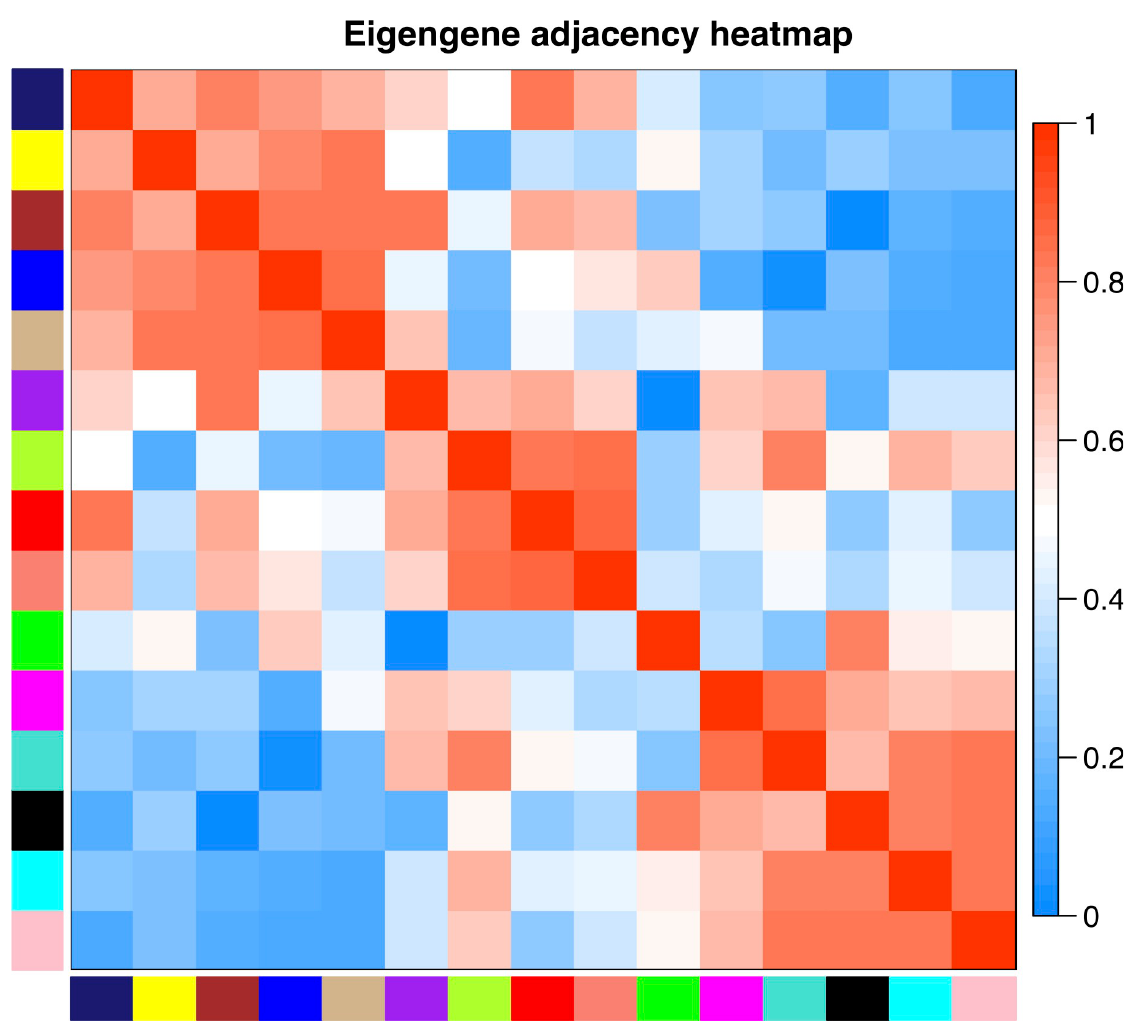
Fig 2. Adjacency heatmap showing the relationships among the module eigengenes. Module eigengenes can be thought of as the weighted average gene expression of all genes in a module. For each pair of eigengenes E I , E J , adjacency is calculated as (1 + cor(E I , E J ))/2. Red represents positively correlated modules and blue represents negatively correlated